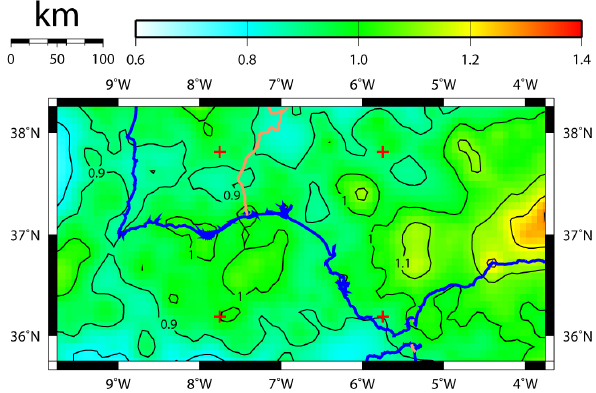
Figure 8. Contours of b k in the south-west of the peninsula. This parameter, which arises from the calculations, is comparable to the b parameter of the Gutenberg–Richter